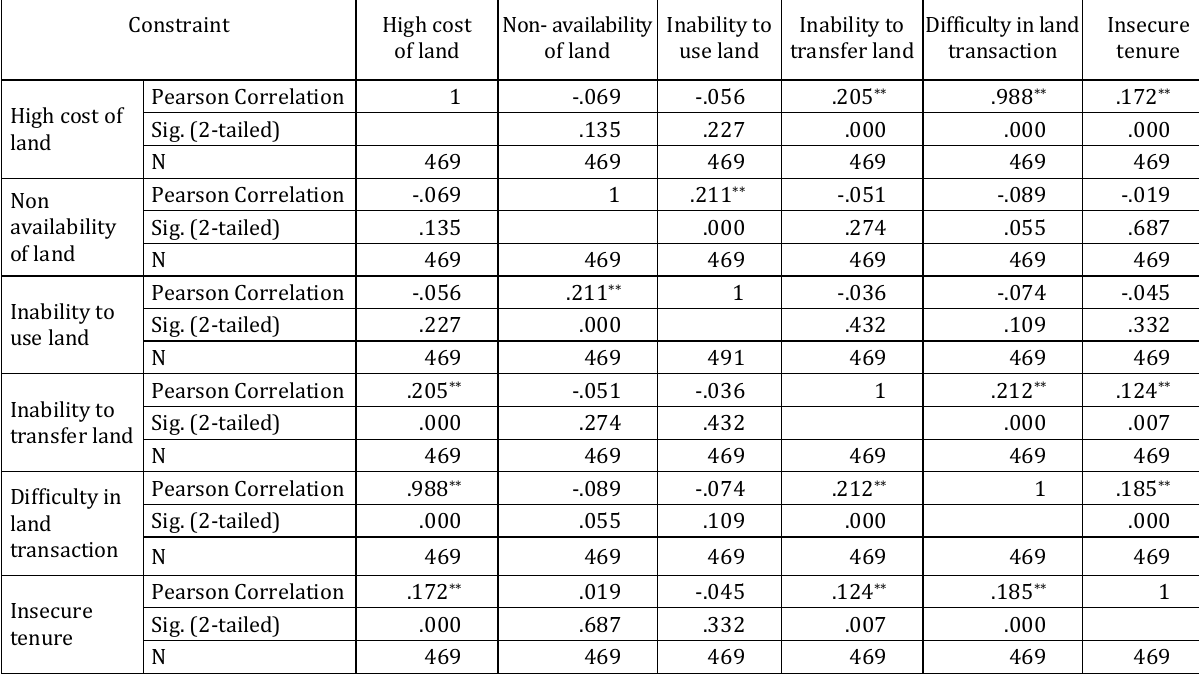
Table 6. Correlations between land accessibility constraint indicators in the study area (Source: Author’s field work,